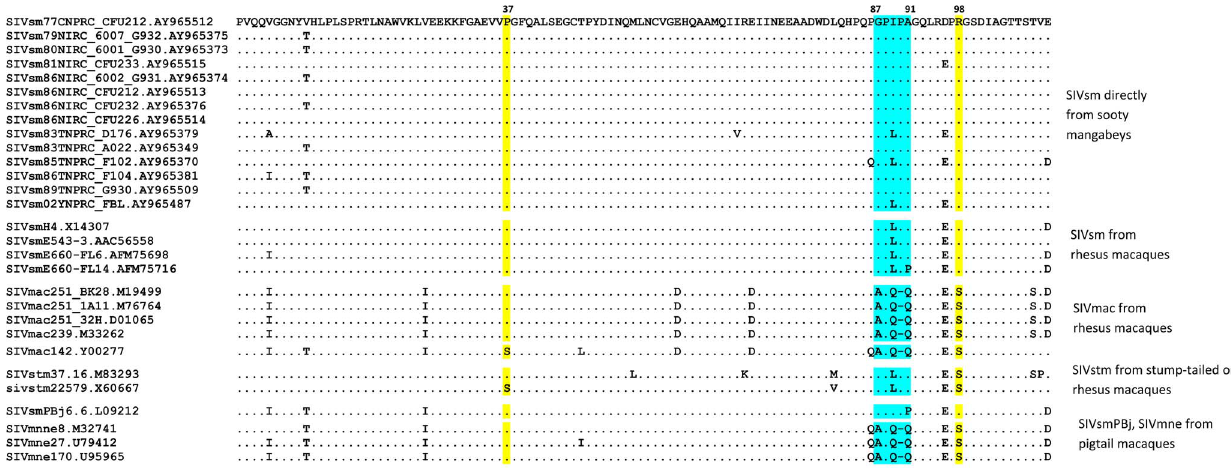
Figure 7. Variance of SIV capsid sequences is associated with their passage history in macaques. The capsid N-terminal domain of SIV clones, with or without passage in rhesus, stump-tailed and pigtail macaques, were aligned to a primary SIVsm clone from sooty mangabey (top). Identical amino acids were shown as a dot (.), deletions are shown as a dash (-). The sites under TRIM5 selection are highlighted in yellow and the Cyclophilin-A binding site is highlighted in light blue and the critical amino acid residues identified as responsible for escape from TRIM restriction are indicated by numbers above the sequence.